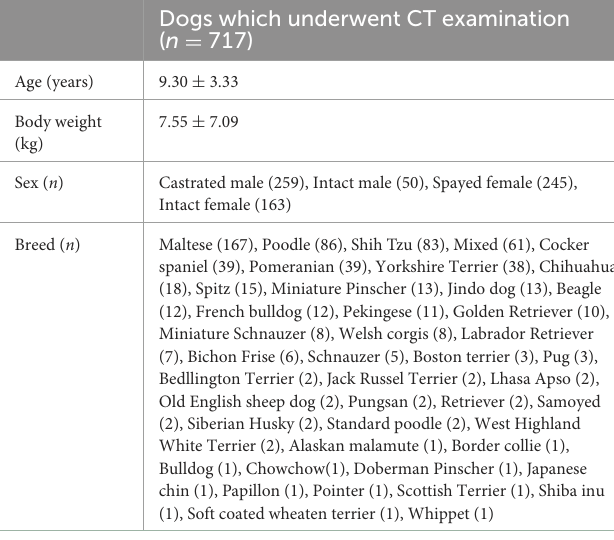
TABLE 1 The characteristics and breed distribution of 717 dogs underwent CT examination.